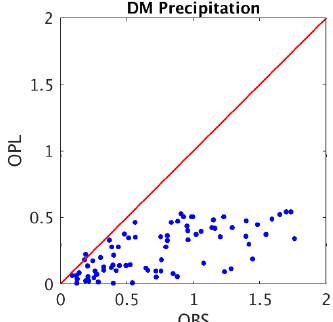
Figure 2. The steps of running open loop (OPL) and data assimilation (DA) experiments with hourly and six-hour assimilation windows.